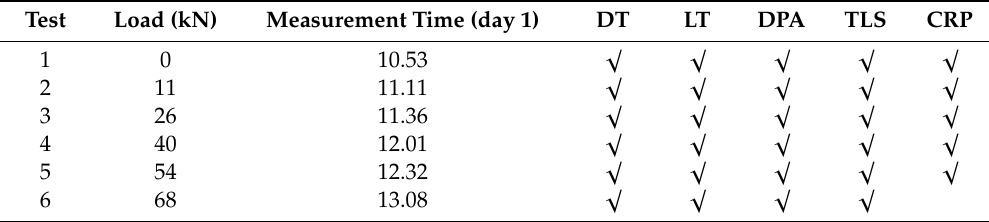
Table 1. Plan of the performed measurements beam#1 first load condition (LC1).